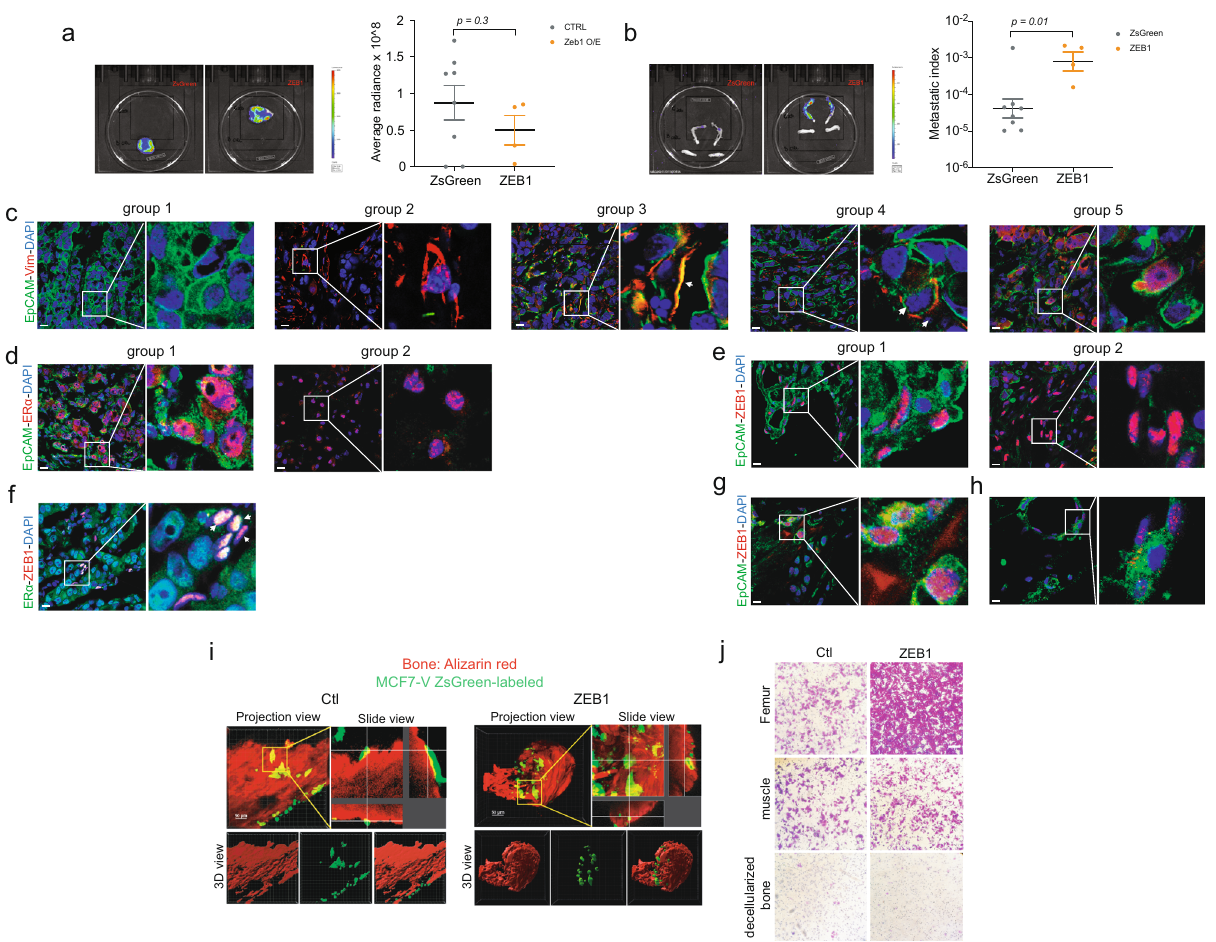
Fig. 7 ZEB1 promotes bone metastasis in vivo. a Left panel shows the Bioluminescent images (BLI) of primary tumors of mice injected with one million ZsGreen- or ZEB1-expressing wild-type MCF7 cells into the mammary fat pad. The panel on the right is the corresponding quantitative analysis of the average radiance of multiple primary tumors. An unpaired and two-tailed Student ’ s t test was applied to determine whether tumor sizes are different ( n = 8 independent animals for ZsGreen cells and n = 4 for ZEB1 cells; means ± SEM). b Left panel is the BLI images showing metastatic lesions in hindlimb bones of ZsGreen- or ZEB1-expressing wild-type MCF7 cells, respectively. The corresponding panel on the right is a bar graph of the metastatic indices (the ratio of the average radiance of metastases over that of the corresponding primary tumor; see Methods for details) for bones ( n = 8 independent animals for ZsGreen cells and n = 4 for ZEB1 cells; means ± SEM); note that the data are shown after log10 transformation; an unpaired and two-tailed Student ’ s t test was used for the statistical analysis. c – f IF images of EpCAM, vimentin, ER α , and ZEB1, and DAPI staining of resected primary tumors formed by MCF7- ZEB1 cells ( + DOX) following their orthotopic injection into mouse mammary fat pads (Scale bar = 10 μ m). g , h IF images of EpCAM and ZEB1, and DAPI staining of metastatic lesions in femurs of mice xenografted with ZEB1-expressing ( g ) and ZsGreen-expressing ( h ) cells (scale bar = 10 μ m). i Multiphoton confocal microscopy images of an ex vivo bone invasion assay showing the bone explant stained in red with alizarin red and the invading ZsGreen-labeled (green) control (Ctl) or ZEB1-expressing MCF7-V cells. Without ZEB1, the cells remain on top of the bone tissue, whereas ZEB1-expressing cells invade it. The upper left of each panel shows a projection of a Z-stack with 20 images, and in the upper right of each panel a slice of the area delimited by a yellow rectangle. Images were processed and generated with the software Imaris 9.7 to illustrate representative slides and 3D views of bone tissue. Scale bar = 50 μ m. j Transwell assay to evaluate the migration of ZsGreen-labeled control (Ctl) or ZEB1-expressing MCF7-V cells stimulated by bone and muscle tissues. Crystal violet dye was used to stain the migrated cells. Decellularized bone served as a negative control. Images are representative of three independent experiments. Source data are provided as a Source Data fi le. Scale bar = 50 μ